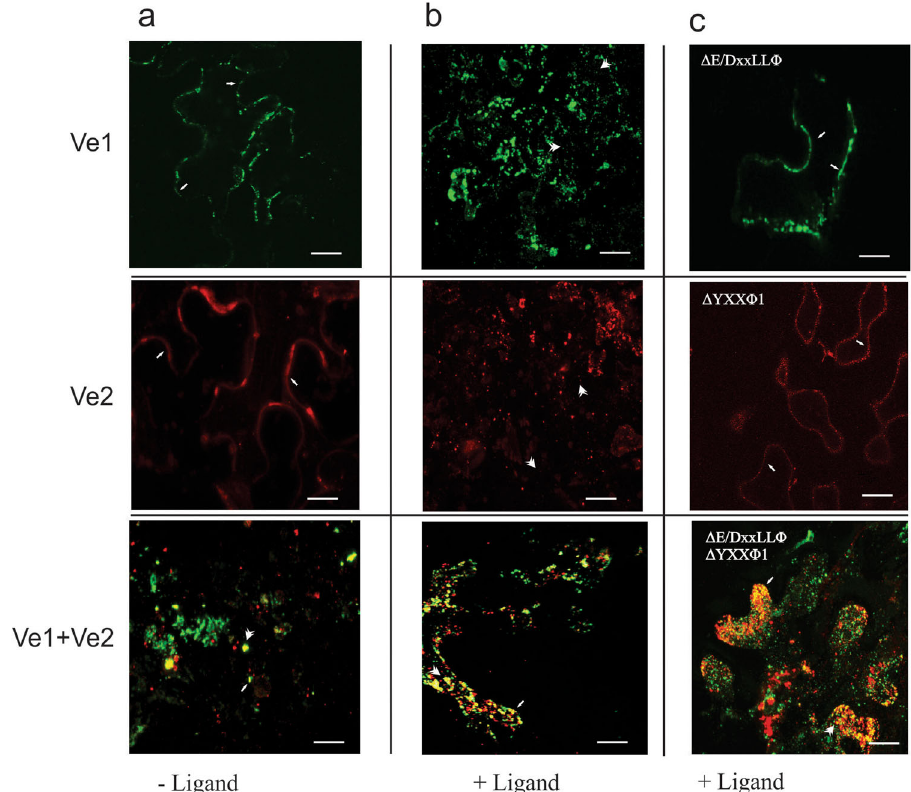
Fig. 3 Cellular localization of the tagged Ve receptors and receptors lacking the pathogen dependent endocytosis signals. Confocal z-stack imaging microscopy of transient Nicotiana benthamiana bioassays 5 days postinoculation. a In the absence of Verticillium dahliae race 1 pathogen ligand (left column), the Ve receptors accumulate at the cell surface (arrows), except when both Ve1 (green) and Ve2 (red) receptors are present (left column bottom row). Image indicates associations between the Ve receptors (yellow) and the occurrence of heteromer endocytosis. b Addition of ligand (middle column) causes both Ve1 and Ve2 individual receptors to be internalized (arrowheads) through ligand dependent endocytosis. c Addition of ligand does not induce endocytosis in the Ve receptors lacking the Ve1E/DxxxL Φ or Ve2Yxx Φ 1 motifs (right column). Elimination of the endocytosis signals also does not impede heteromer endocytosis in cells containing both Ve receptors (bottom right). Confocal differential interference contrast (DIC) bright fi eld microscopy is shown in Fig.